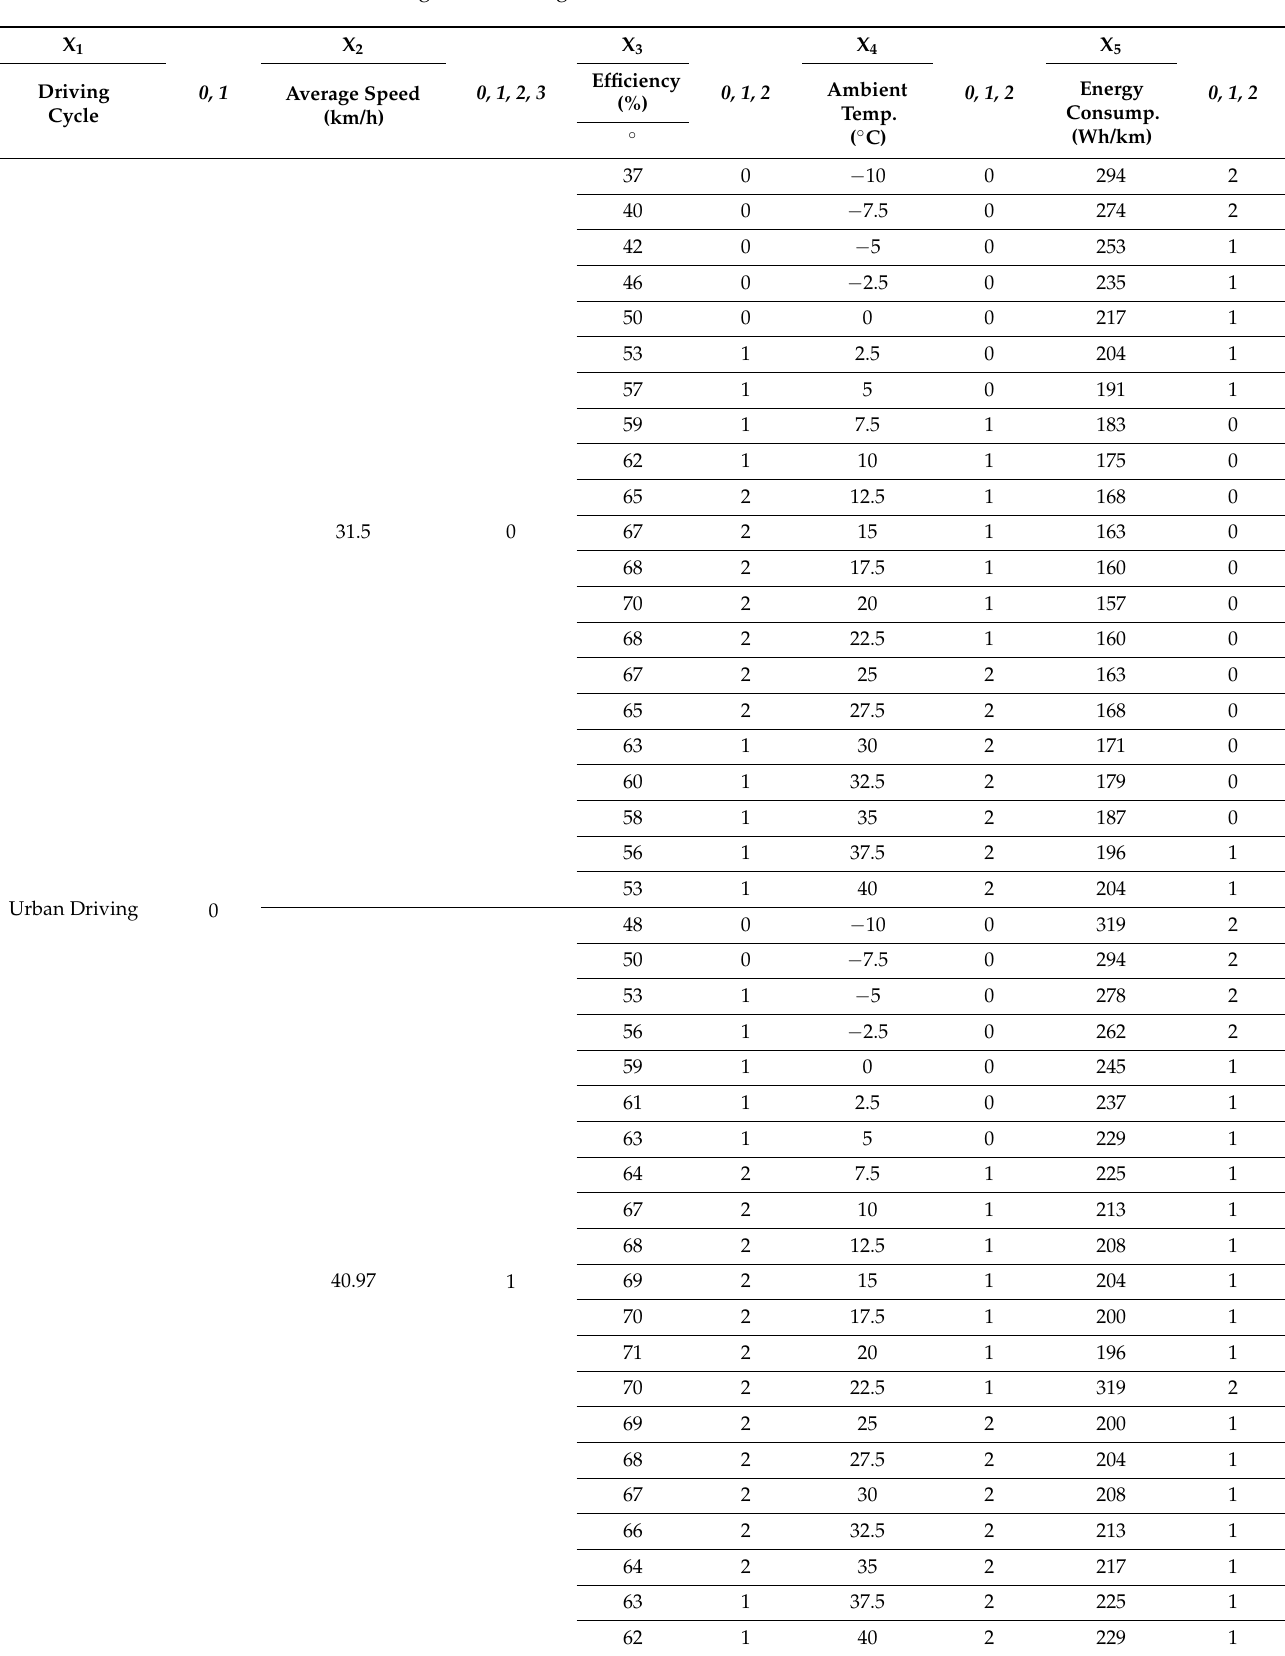
Table 1. Logical code ranges for decision